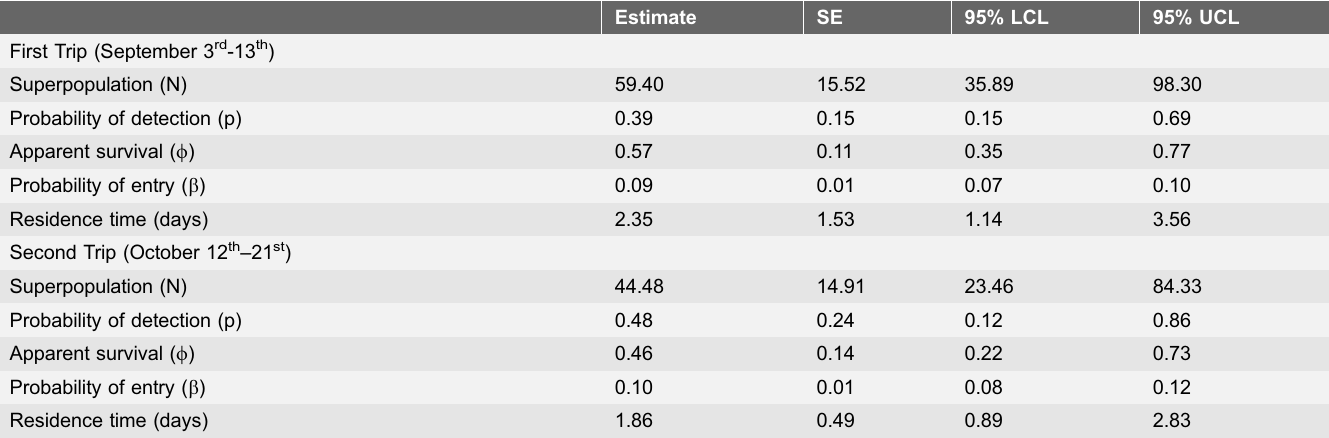
Table 1. Estimates of superpopulation, probability of detection, apparent survival, probability of entry and residence time for 47 whale sharks recorded at Darwin Island, Galapagos Marine Reserve, during two individual survey trips in September and October 2013. Estimate